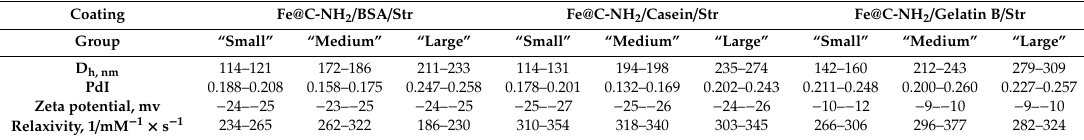
Table 1. Properties of conjugates prepared during size-tuning